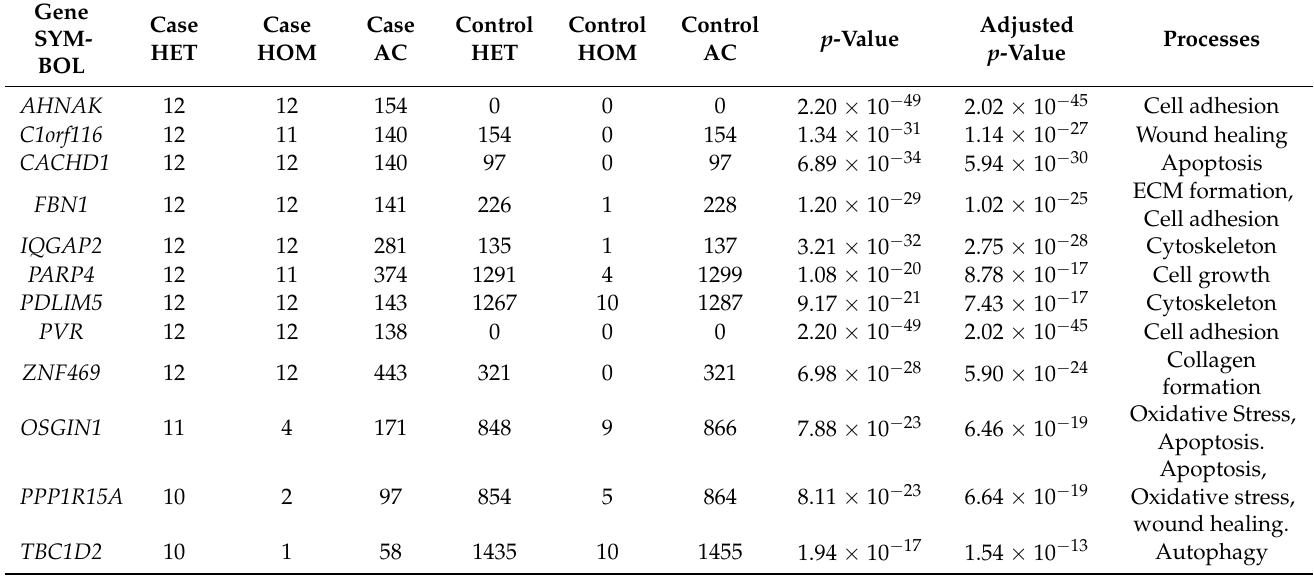
Table 2. Characteristics and processes of the twelve genes related to CIMDL. Case HET: Number of individuals carrying at least one heterozygous qualifying variant in the gene; Case HOM: Number of individuals carrying at least one homozygous qualifying variant in the gene; Case AC: Total Allele Count of qualifying variants in the gene; Control HET: Approximate number of individuals carrying heterozygous qualifying variants in the gene; Control HOM: Number of individuals carrying homozygous qualifying variants in the gene; Control AC: Total AC for the gene; p -value: p -value under the dominant model; Adjusted p -value: p -value corrected with Benjamini-Hochberg procedure; Processes: main function associated to